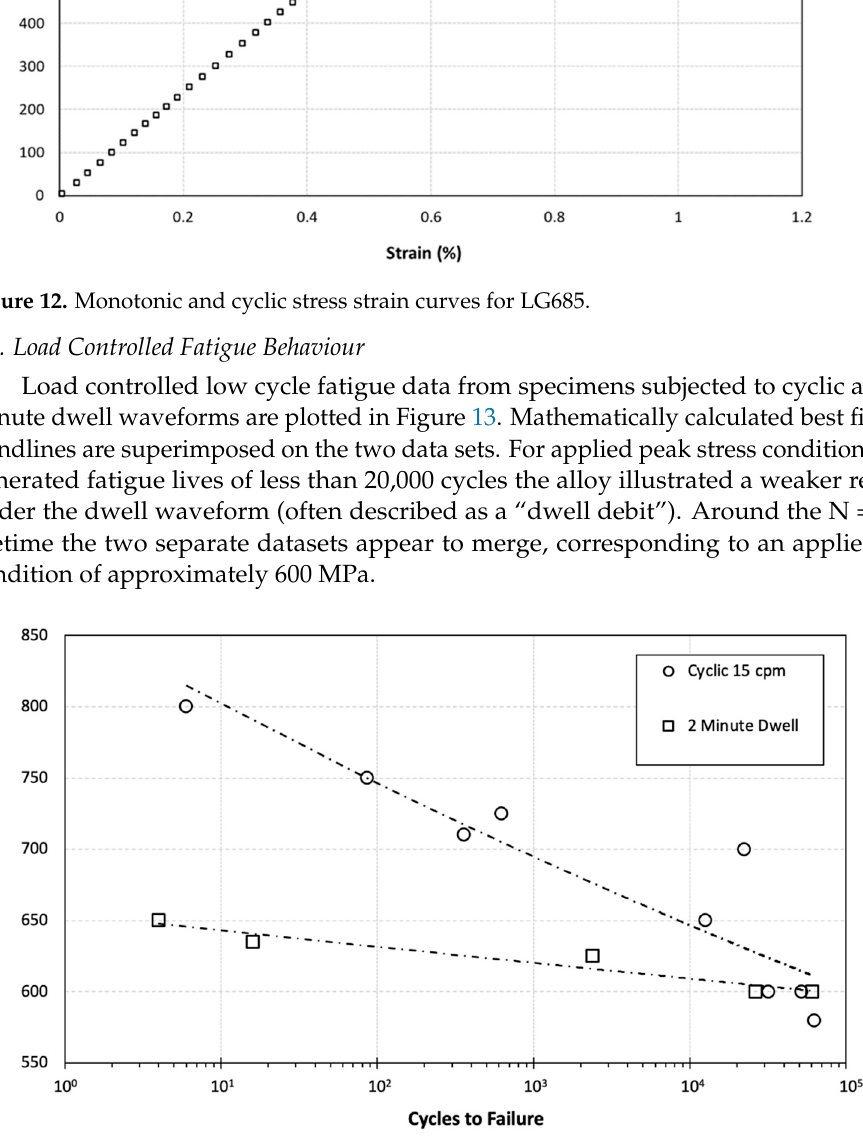
Figure 11. Constitutive behaviour during cycles 1, 2, 8 and 500.